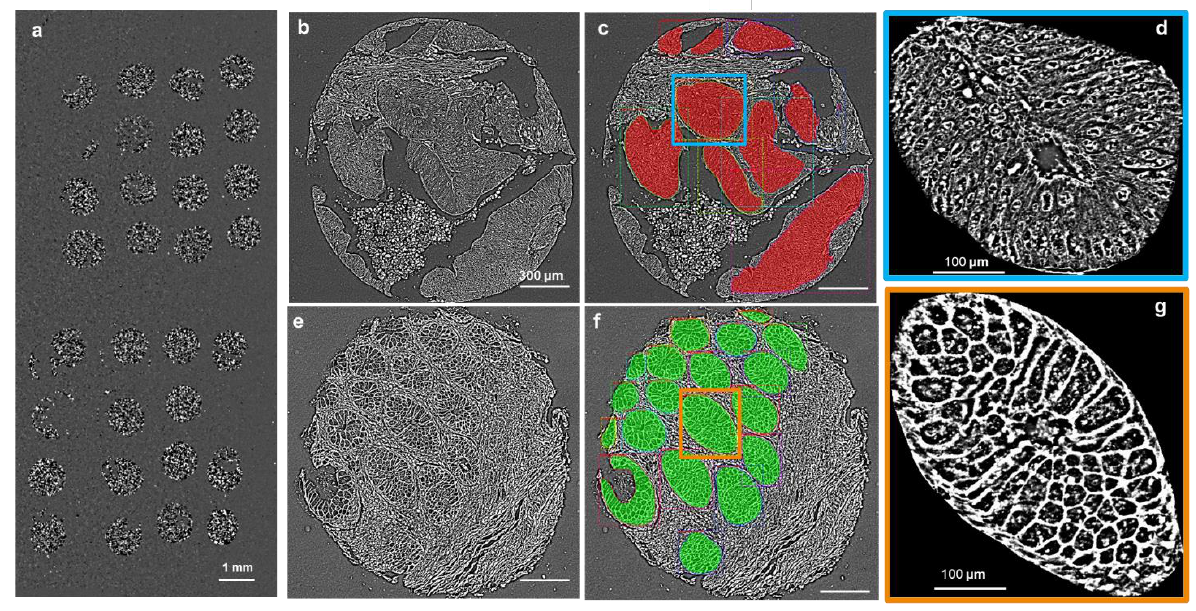
Figure 3. Examples of segmentation and classification. ( a ) Images of the 32 testing cores. ( b ) A cancer core. ( c ) The prediction of gland detection and classification of the core in ( b ). ( d ) A zoomed-in image of the cancer gland boxed in ( c ). ( e ) A normal core. ( f ) The prediction of gland detection and classification. ( g ) A zoomed-in image of the normal gland boxed in ( f ). The red color represents cancer and the green color normal glands.